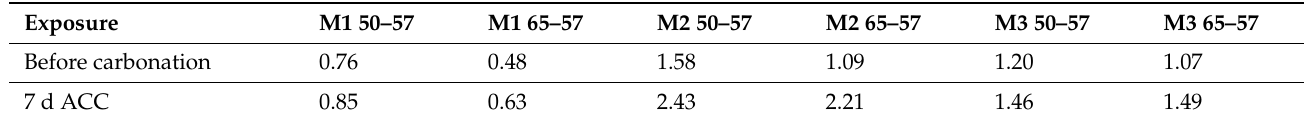
Table 3. Sorption coefficients (kg/(m 2 · h 0.5 )) before and after accelerated carbonation at 57% RH, 3 vol.% CO 2 , 20 ◦ C and ambient, pressure, ACC = accelerated carbonation.